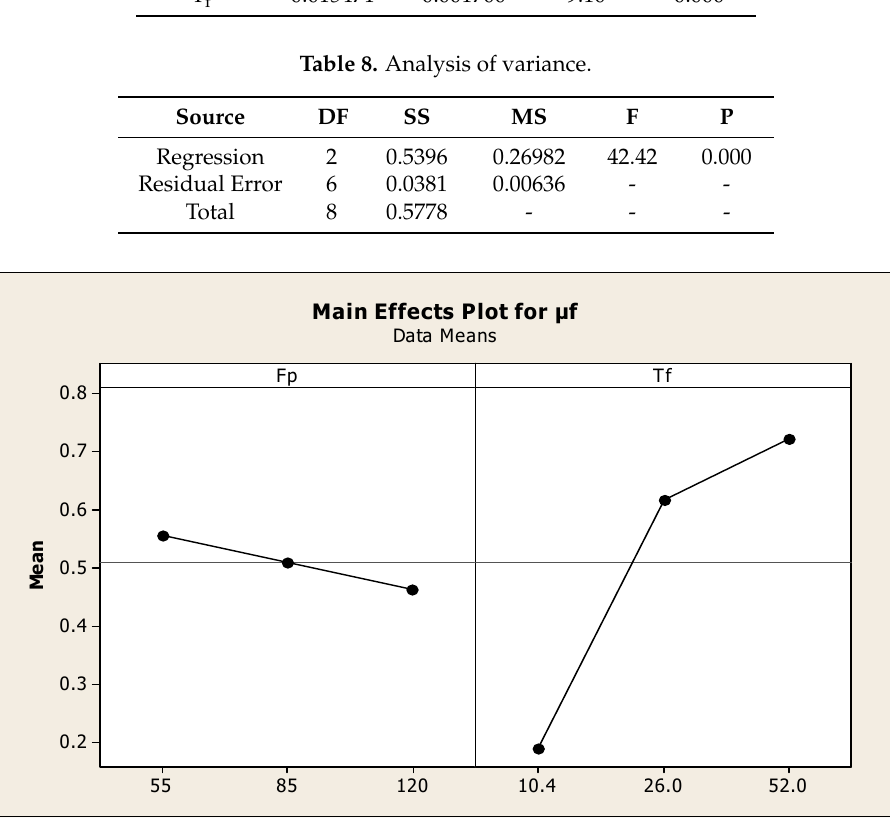
Table 9. Regression equation coefficients.